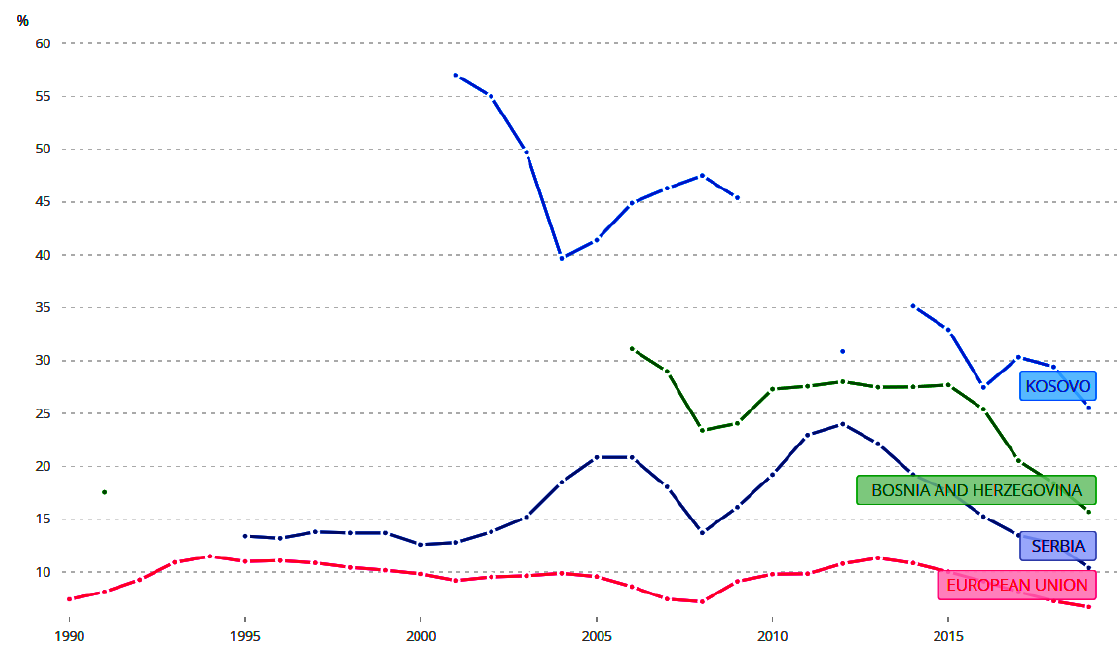
Figure 1. Unemployment trends as percentage of total labour force